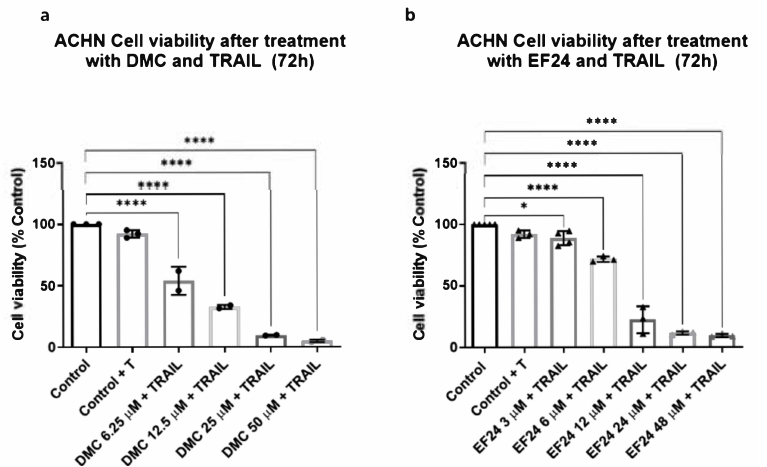
Figure 2. ACHN cell viability measured using MTT assays after 72 h of treatment using either DMC or EF24 in combination with the cytokine TRAIL. ( a ) Cell viability decreases with increasing concentrations of DMC in combination with TRAIL over a 72 h period of time. This decrease is enhanced by addition of TRAIL in comparison to values from Figure 1a. Combination treatment of DMC and TRAIL at 12 µ M significantly reduces cell viability to 32.73% ( b ) Treatment with increasing concentrations of EF24 in combination with TRAIL reduces ACHN cell viability more than the EF24 monotherapy, up to 22.25% at 12 µ M and 11.39% at 24 µ M. Results shown are an average of 4 independent experiments. * p ≤ 0.05, **** p ≤